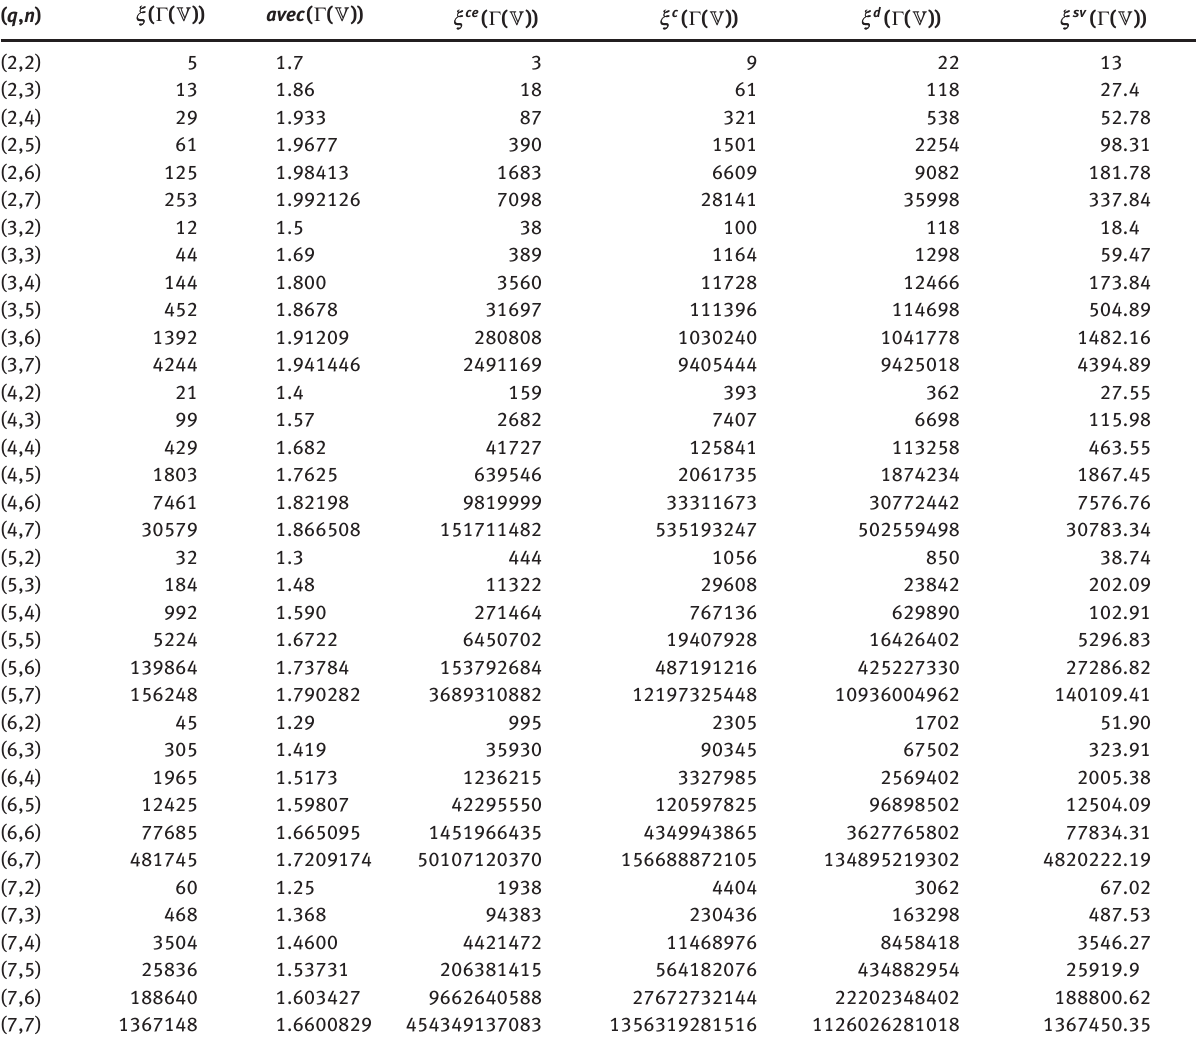
Table 2: Numeric comparison of the investigated indices at certain values of q and n .